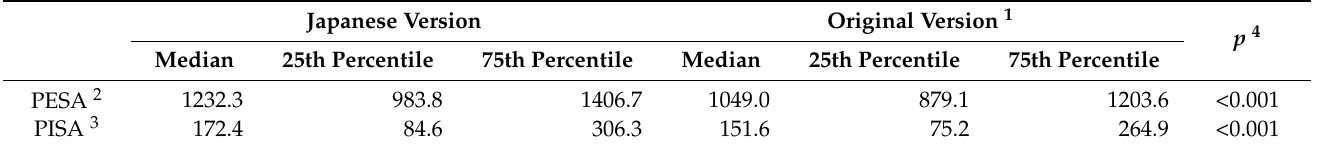
Table 3. Comparisons of periodontal epithelial surface area (PESA) or periodontal inflamed surface area (PISA) of the Japanese version and the original version using clinical data ( n =